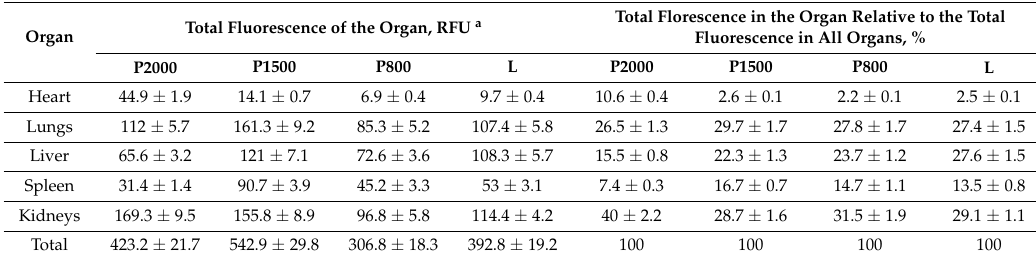
Table 3. Accumulation of Cy5.5-labeled siMDR complexed with liposome P800 , P1500 , P2000 or L formed at N/P of 4/1 in the organs of healthy SCID mice, 24 h after i.v. injection. a Total Florescence in the Organ Relative to the Total Organ Total Fluorescence of the Organ, RFU Fluorescence in All Organs, % P2000